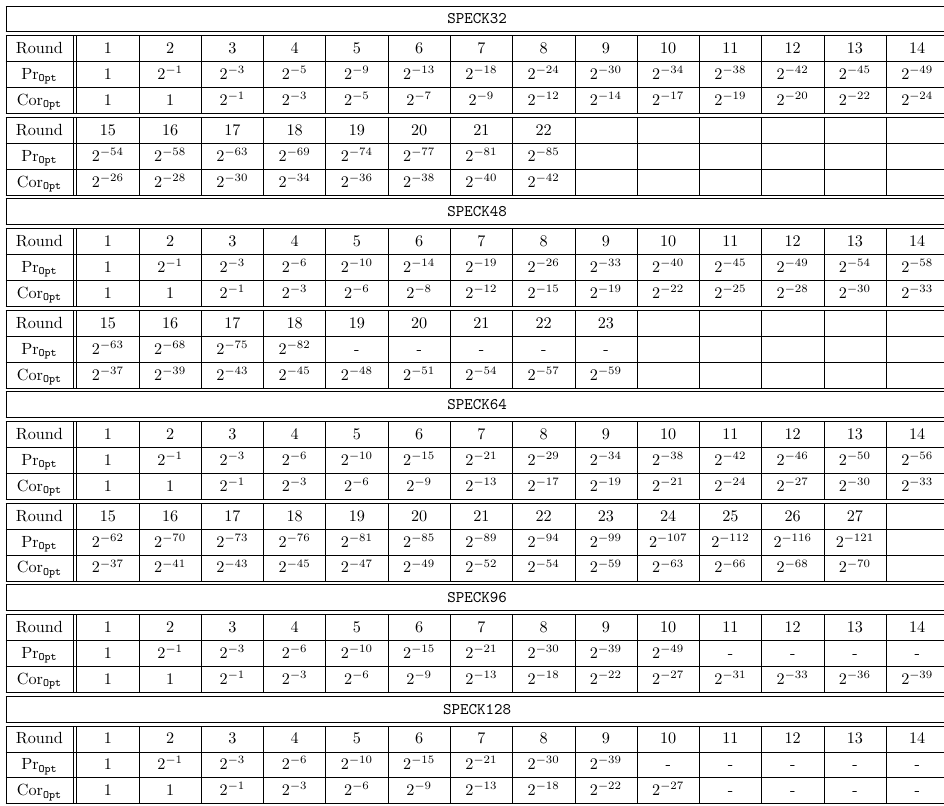
Table 10: Experimental results of SPECK Family of Block